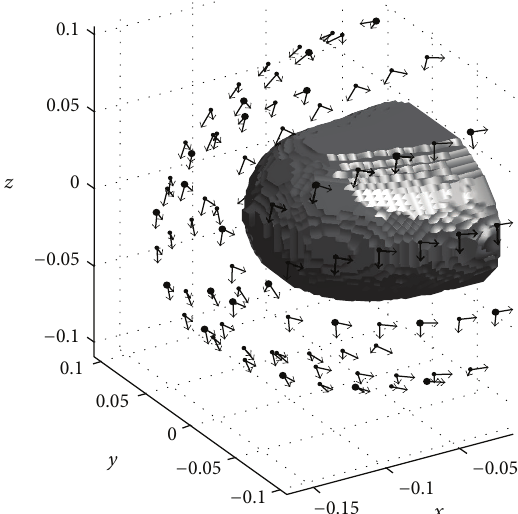
Figure 15: A view of the dipole configuration for the realistic breast phantom. Dipole positions are indicated with dots and orientations with arrows. All dipoles act as receiver and transmitting dipoles are indicated with larger dots. The gray shape represents the outline of the breast phantom. Distances are in